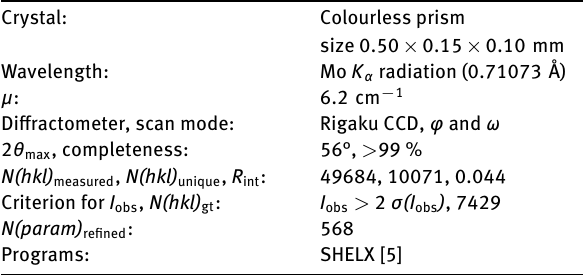
Table 2: Fractional atomic coordinates and isotropic or equivalent isotropic displacement parameters (Å 2